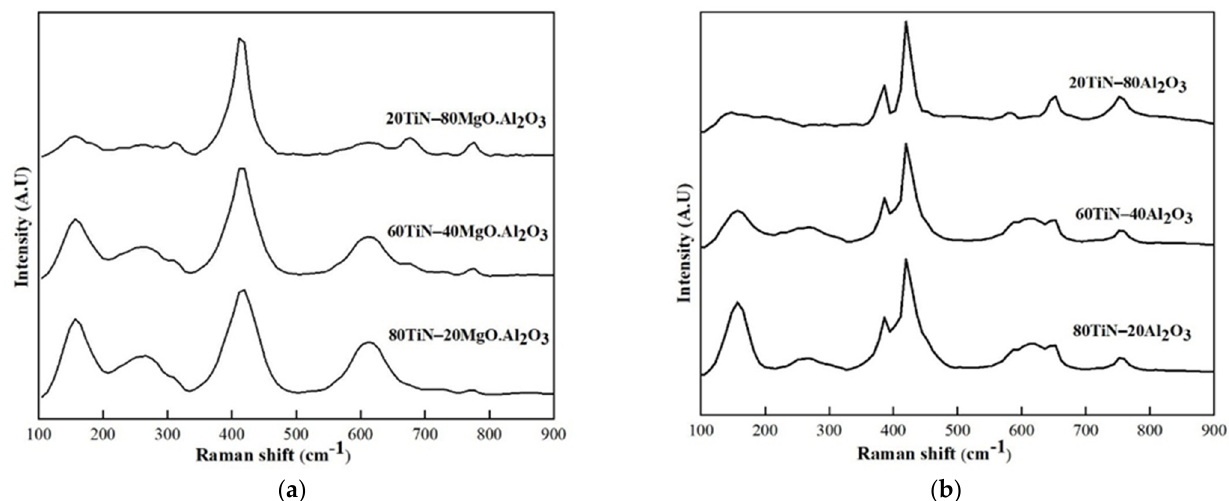
Figure 2. Raman spectra measured from binary samples used to establish a relationship between the phase content and relative peak intensity, where ( a ) is for TiN–MgO·Al 2 O 3 and ( b ) is for TiN–Al 2 O 3 .